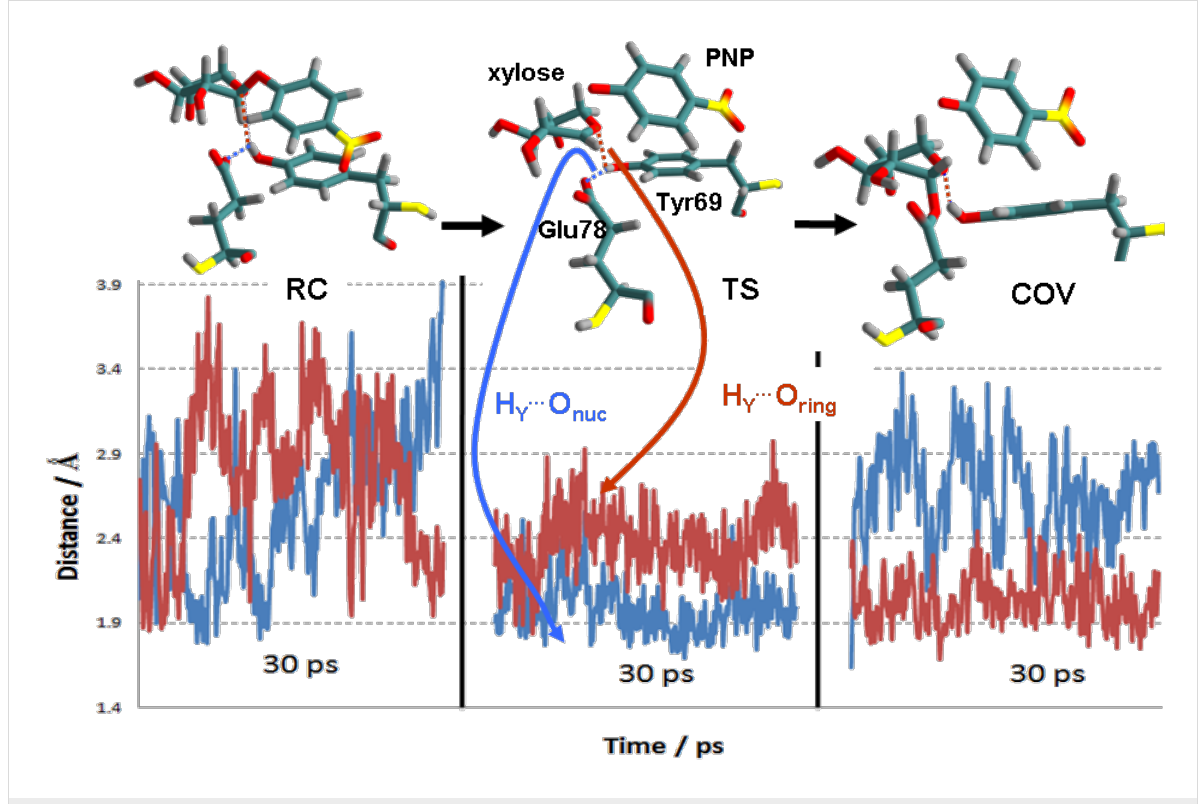
Figure 7: Hydrogen-bond distances H Y… O ring (red) and H Y… O nuc (blue) to boat conformer of RC, TS and glycosyl-enzyme COV intermediate, as shown by QM/MM MD simulation in active site of